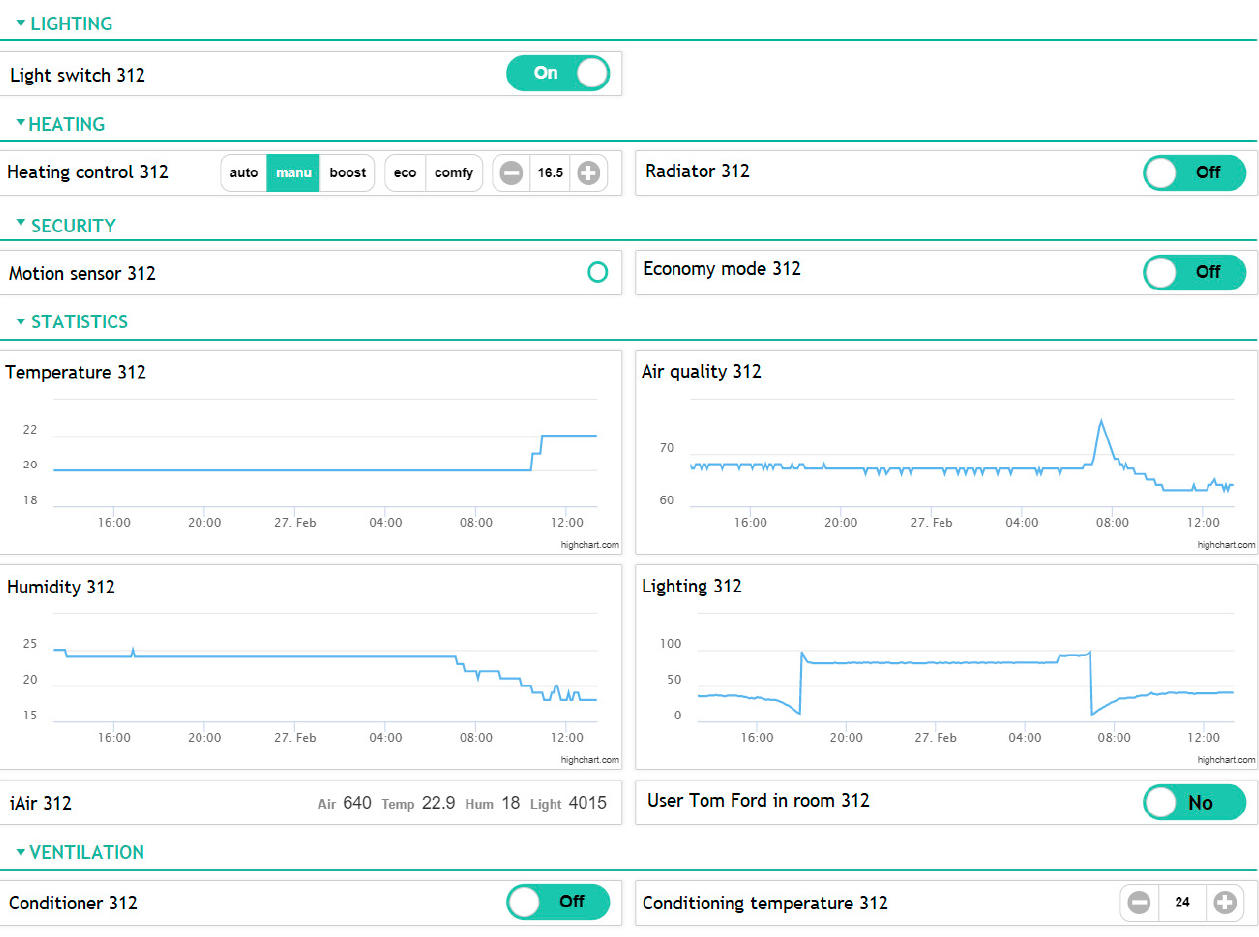
Figure 9. Pimatic user interface controlling house environment.